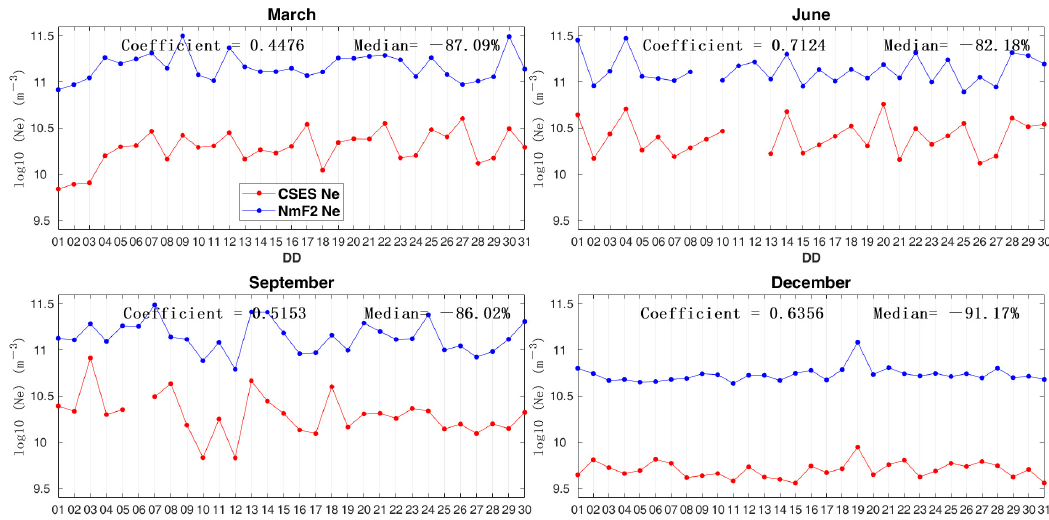
Figure 8. Time series of Ne for CSES and Lhasa ionosonde in different months. In each panel, the red curve represents CSES Ne and the blue curve denotes Ne at the satellite altitude inferred by Lhasa ionosonde observations and IRI model. The two time series are displayed with a log scale. In the same way as for the Lhasa station, the correlation coefficients between the CSES and ionosonde Ne for each station from CRIRP were calculated according to Equa- tion (3) for March, June, September and December of 2019, which was summarized in Table 1. For a more intuitive representation, the differential correlation coefficients by 1° × 1° were obtained based on all of the data in Table 1; the contour lines with colors are shown in Figure 9, where the name of each station is used the abbreviation. It can be seen that the values at the low to mid-low latitudes are mostly higher than those at the middle latitude, which is more obvious in June, September and December. In general, the corre- lation between the two datasets in June and September is relatively better than that in other months, with the highest value in June for the CC, LZ, LS and CQ stations, and in September for the BJ, XA and KM stations. Table 1. Correlation coefficient between CSES and ionosonde Ne at different ionosonde stations. Station